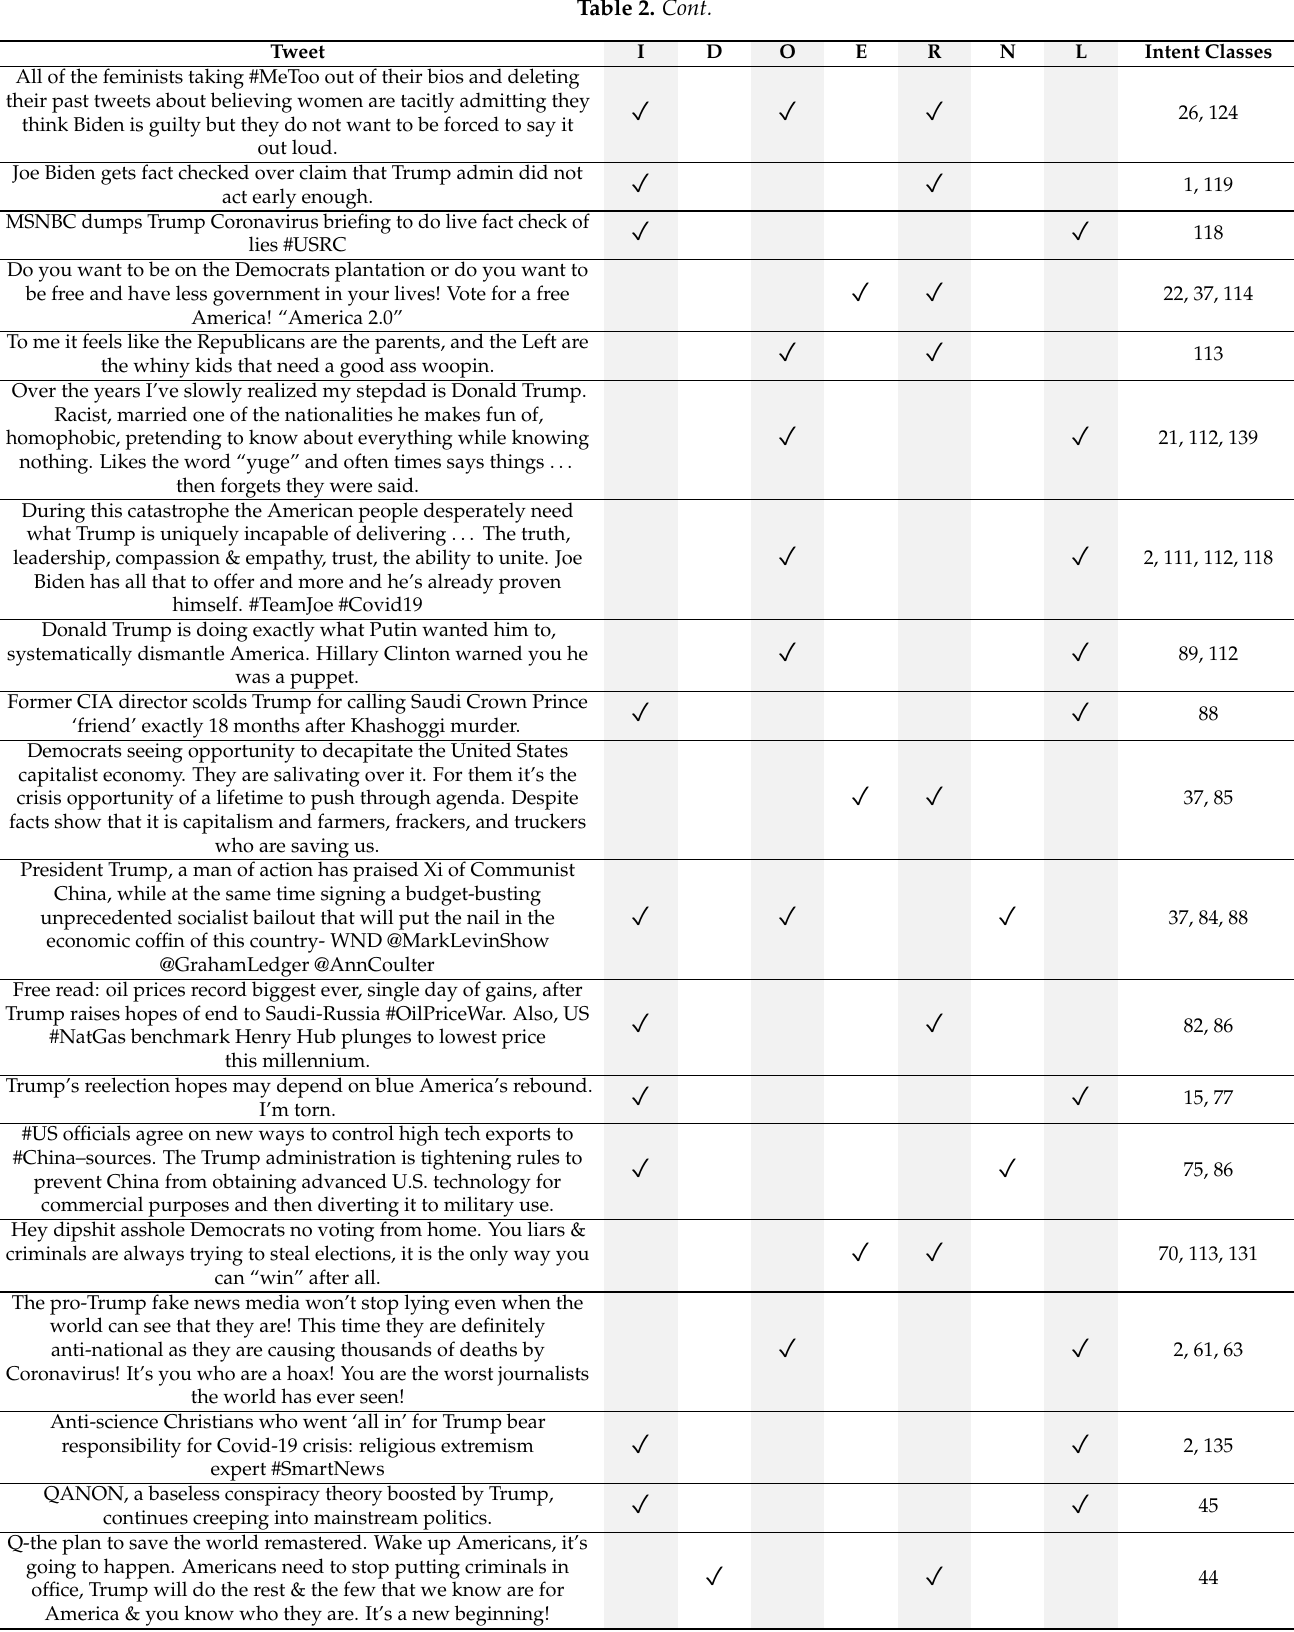
Table 2. Example Tweets and their classes: I stands for information, D for disinformation, O for opinion, E for extreme opinion, R for rightist, N for neutral, and L for leftist.